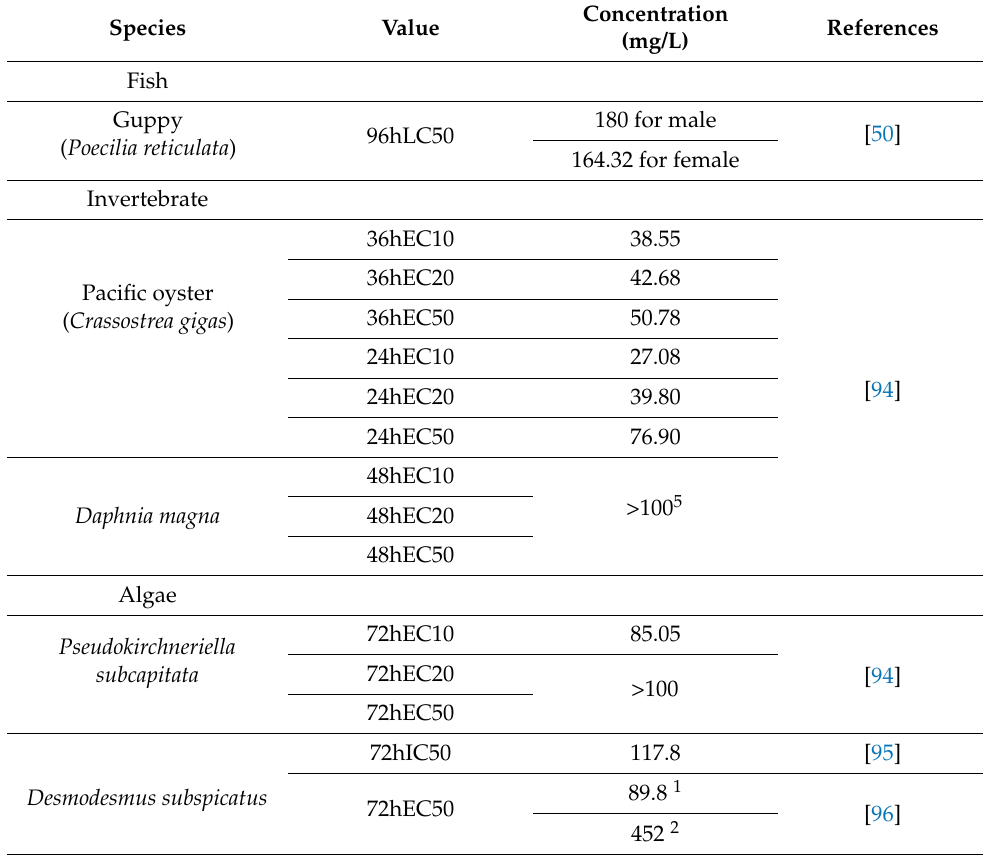
Table 6. Toxicity values of AMPA for aquatic organisms.